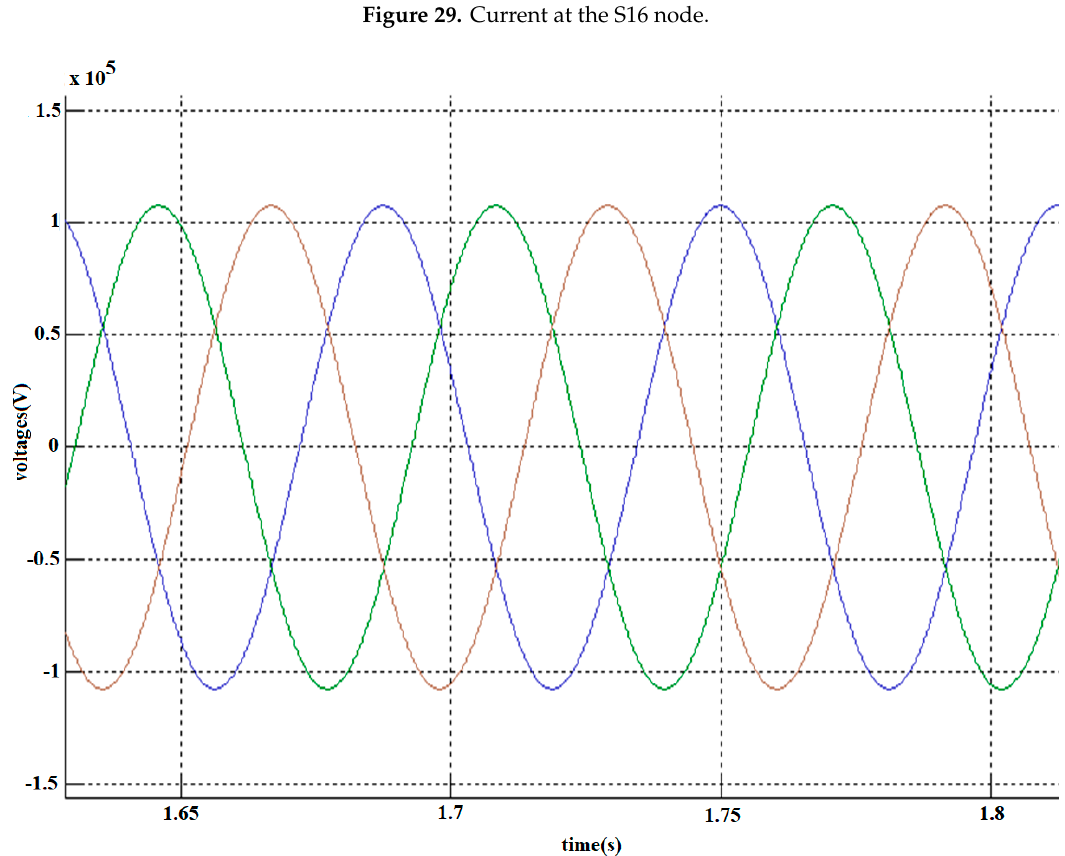
Figure 30. Voltages at the S16 node.